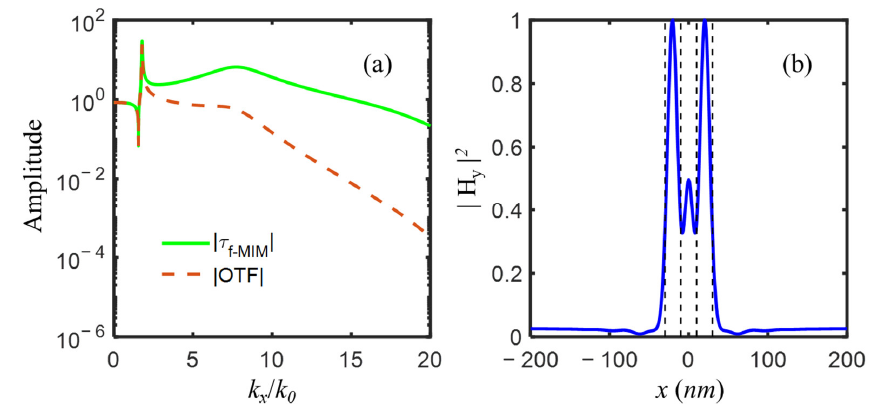
Figure 7. Real part of effective mode indices n ef f = k x / k 0 of s-LRSPP, a-SRSPP, and s-SRSPP of IMIMI waveguide for variant refractive index d of central dielectric layer from 1 to 3 with an increment of 0.02.